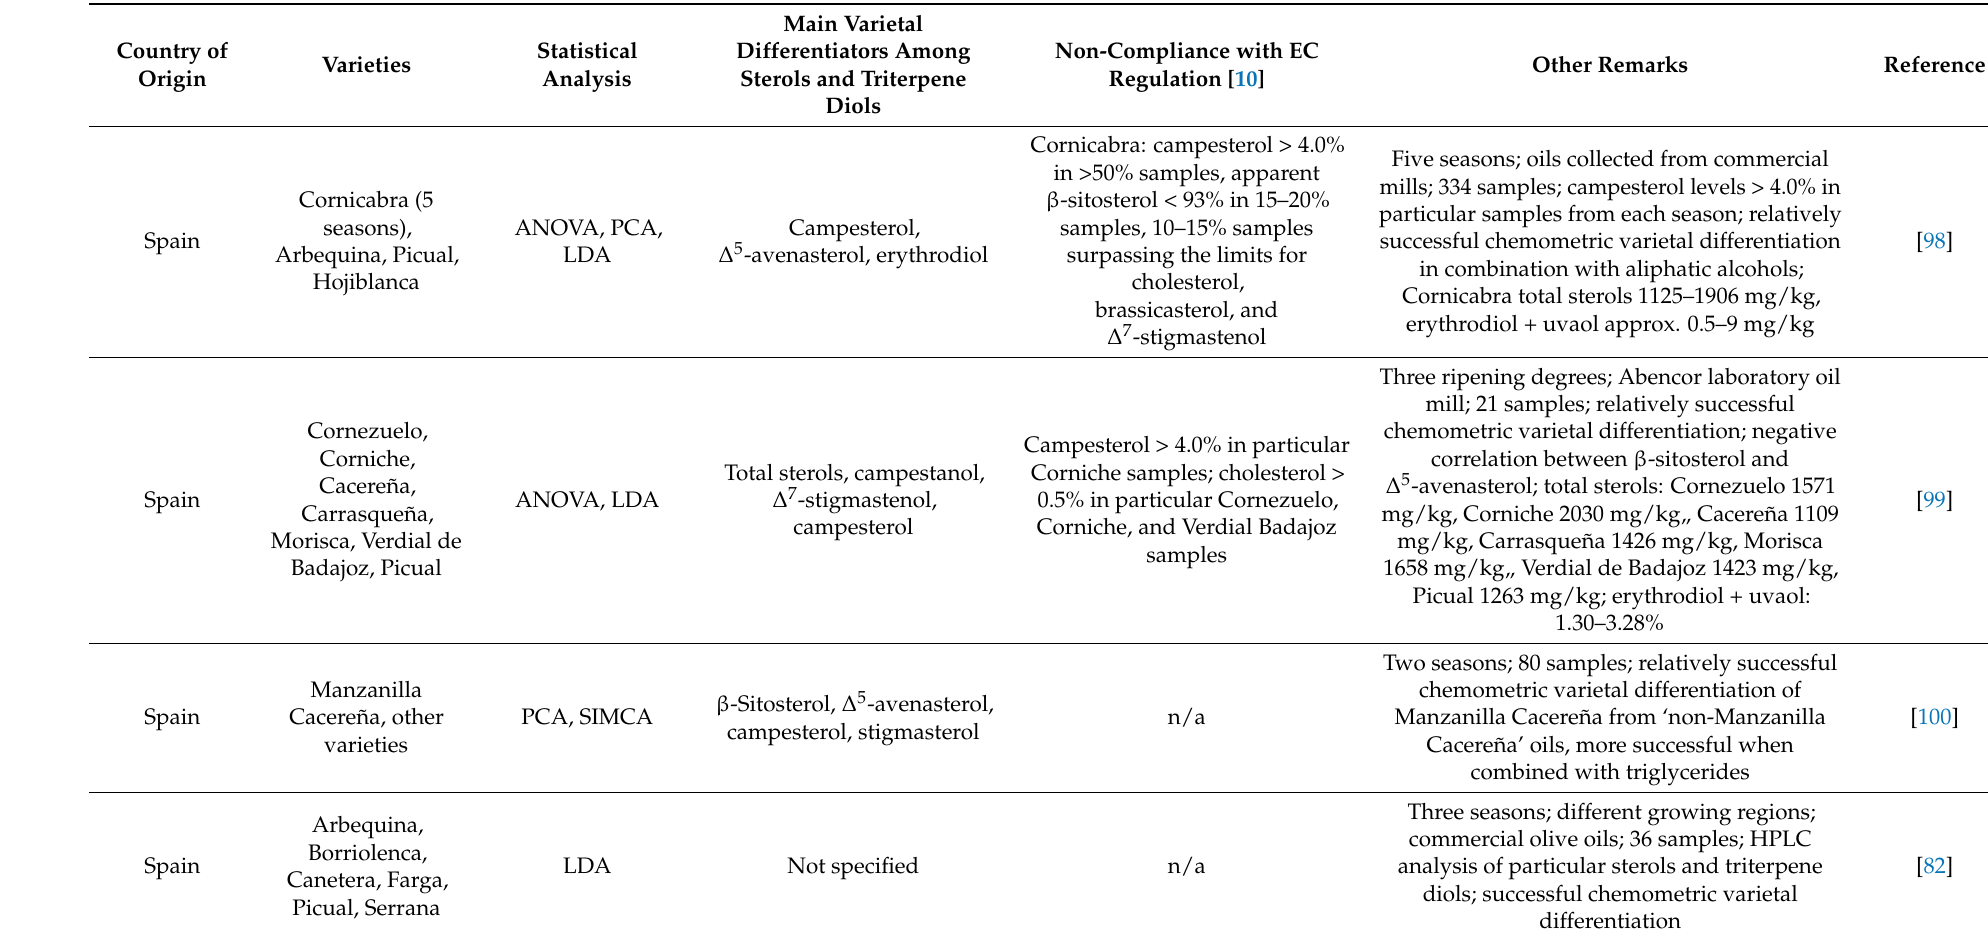
Table 2. Virgin olive oil varietal characterization and differentiation studies based on the content and composition of sterols and triterpene